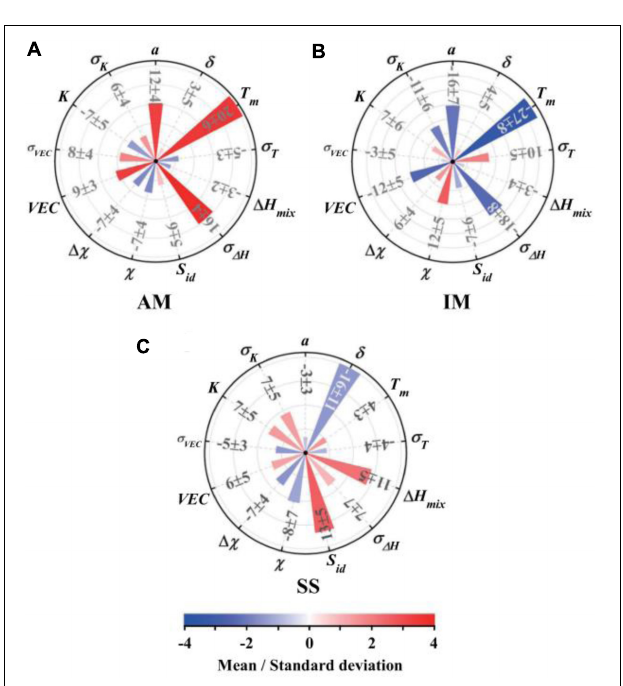
FIGURE 6 | The sensitivity measures of the 13 parameters for (A) amorphous phase, (B) intermetallics, and (C) solid solution based on the result of the artificial neural network model. Here, a, T m , (cid:49) H mix , χ , VEC, and K are the mean value of atomic radius, melting point, mixing enthalpy, electronegativity, valence electron concentration, and bulk modulus, respectively. δ , σ T , σ (cid:49) H , (cid:49) χ , σ σ K are their corresponding standard deviation value, VEC , and respectively. S id is the mixing entropy (Agnew et al.,